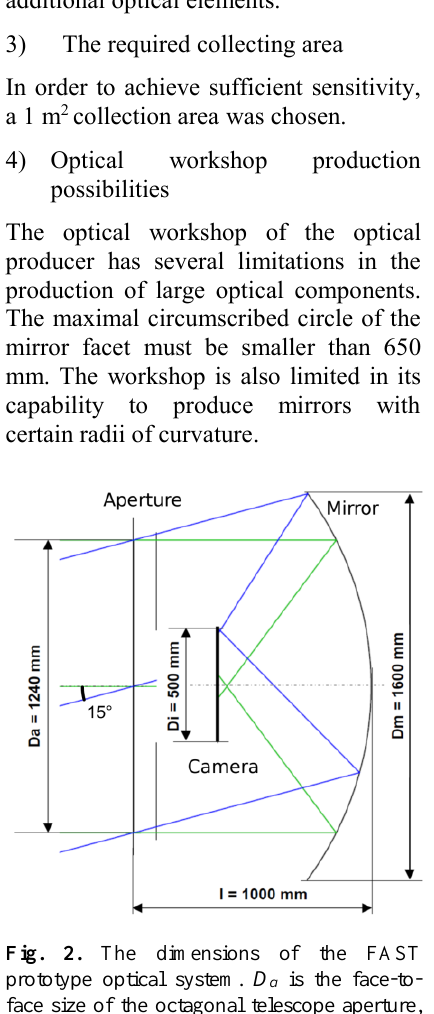
(figure 3). The final and optimal solution uses one central circular mirror surrounded by 8 “petals” (right picture figure 3). The selection was based on the mirror effective area and manufacturing